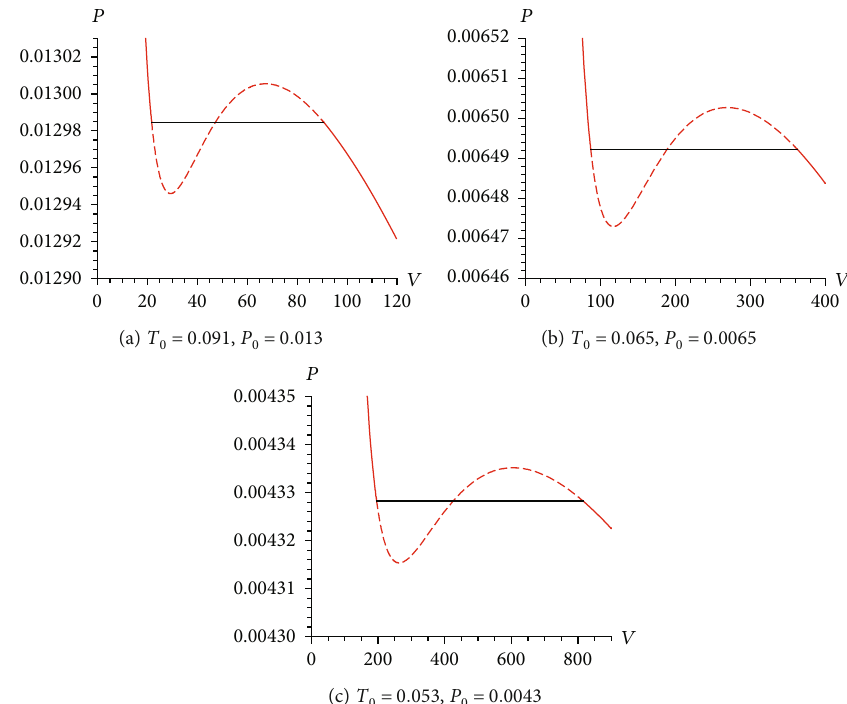
/ r = 0 : 7 (i.e., χ = T / T = 1 2 0 c